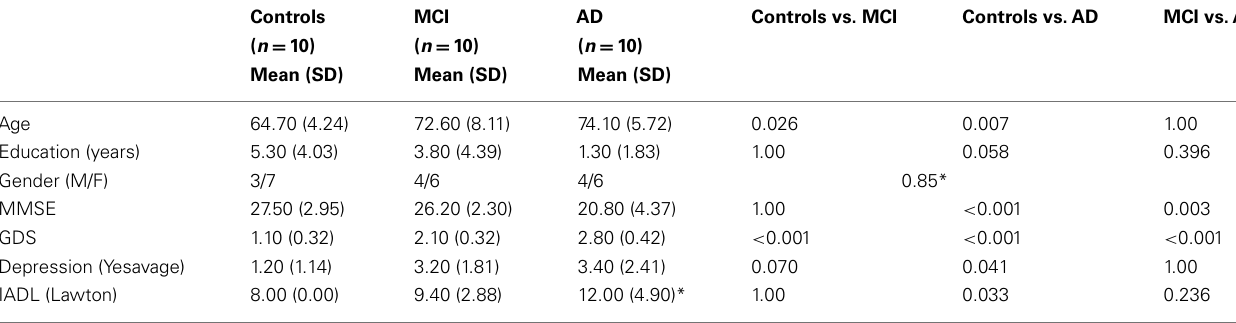
Table 1 | Demographic, psychometric and functional variables in the selected